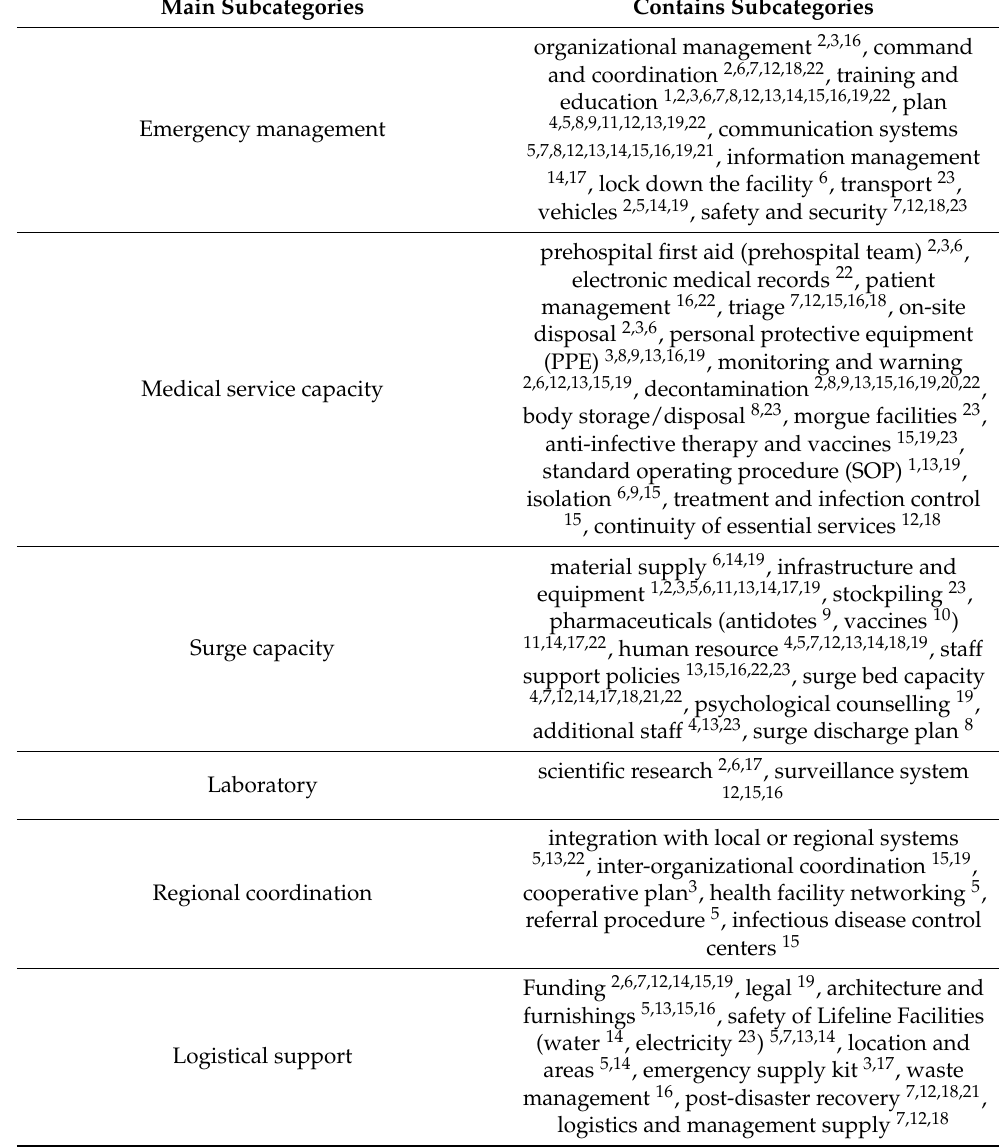
Table 4. Main subcategories of hospital response to bioterrorism (superscript numbers correspond to the numbers in the document information